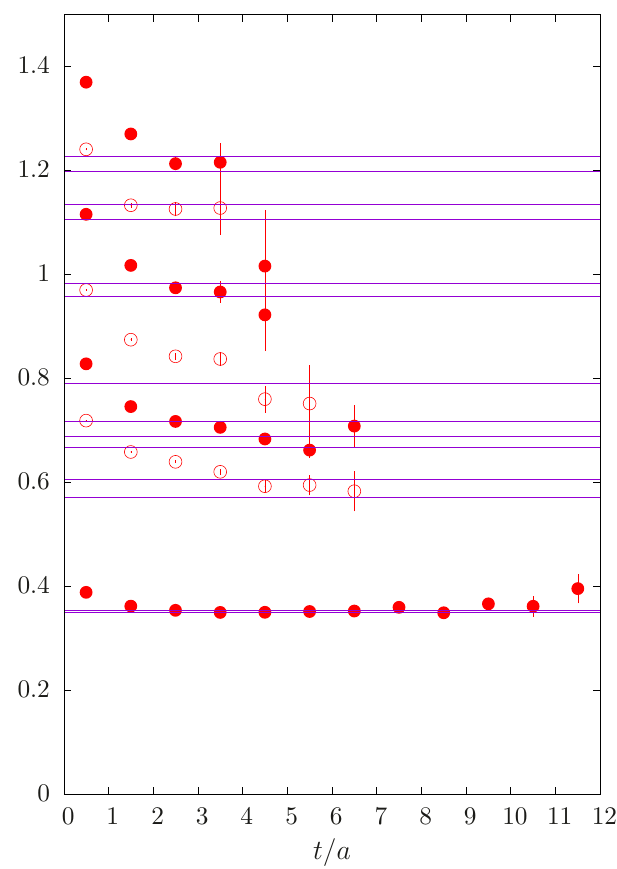
Figure 9 . E(cid:11)ective energies of the ground state Pfa(cid:14)an string in SO(4) at (cid:12) = 15 : 1 for lengths l = 18 ; 30 ; 34 ; 38 ; 42 ; 46 ; 50 in order. Pairs of lines are